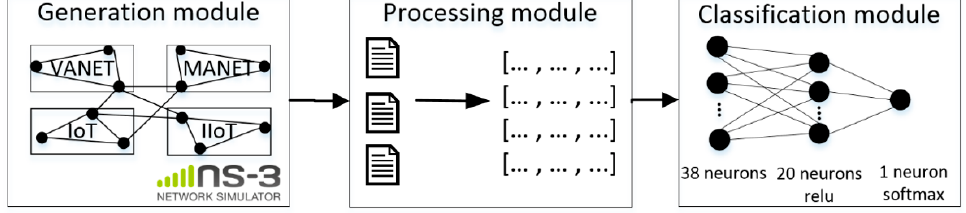
Figure 13. The experimental setup.